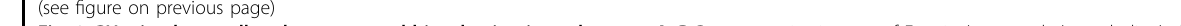
Fig. 3 GH stimulates cell cycle reentry and binucleation in podocytes. A , B Representative images of F-actin (green color), α -tubulin (yellow color), and counterstained with DAPI (blue color) staining in human podocytes treated with or without treatment for 48 h. Magni fi cation ×630. Scale bar = 20 μ m. ( n = 3). C The graph represents the % of binucleated podocytes from the above experimental conditions. Mean ± SD. ( n = 4). Each data point represents the average value of fi fty cells. D The graph represents the % of podocytes accumulated in anaphase from the above experimental conditions. Mean ± SD. ( n = 4). C , D *** p < 0.001 and **** p < 0.0001 by one-way ANOVA post hoc Dunnett test. Each data point represents the average value of fi fty cells. E Cell cycle phases of podocytes from indicated experimental conditions ( n = 4). F Immuno fl uorescence for the Ki67 (red color) and counterstained with DAPI (blue color). Magni fi cation ×630. Scale bar = 20 μ m. ( n = 3). G Representative images of immunohistochemistry for anti-Ki67 expression by DAB staining in mice glomerular sections. Quanti fi cation of Ki67-postive glomeruli (right panel) where each dot represents the average value of ten glomeruli from each mouse. Black arrow indicates speci fi c expression of Ki67 in podocytes. Magni fi cation ×630. Scale bar = 20 μ m. ( n = 3). **** p < 0.0001 by one-way ANOVA post hoc Dunnett test. H , I Immunoblotting analysis in human podocytes and mice primary podocytes. ( n = 3). J Representative images of immunostaining for CDK4 (red color) and counterstained with DAPI (blue color) in mice glomeruli. Magni fi cation ×630. Scale bar = 20 μ m. ( n = 3). White arrowhead indicates speci fi c expression of CDK4 in the